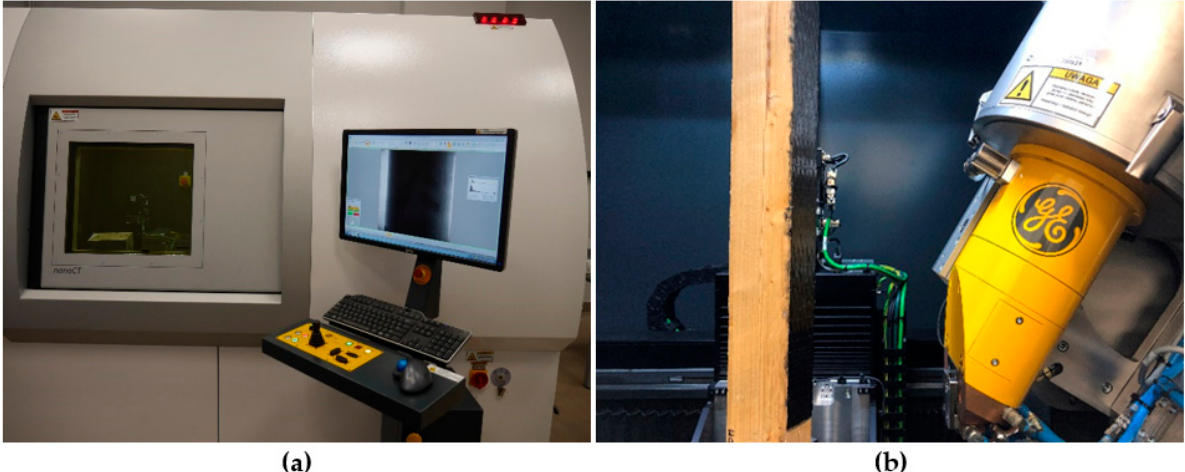
Figure 5. X-ray CT examinations: ( a ) the GE Phoenix v-tome-x m device during the test; ( b ) a sample prepared for tomographic examination mounted inside the device.